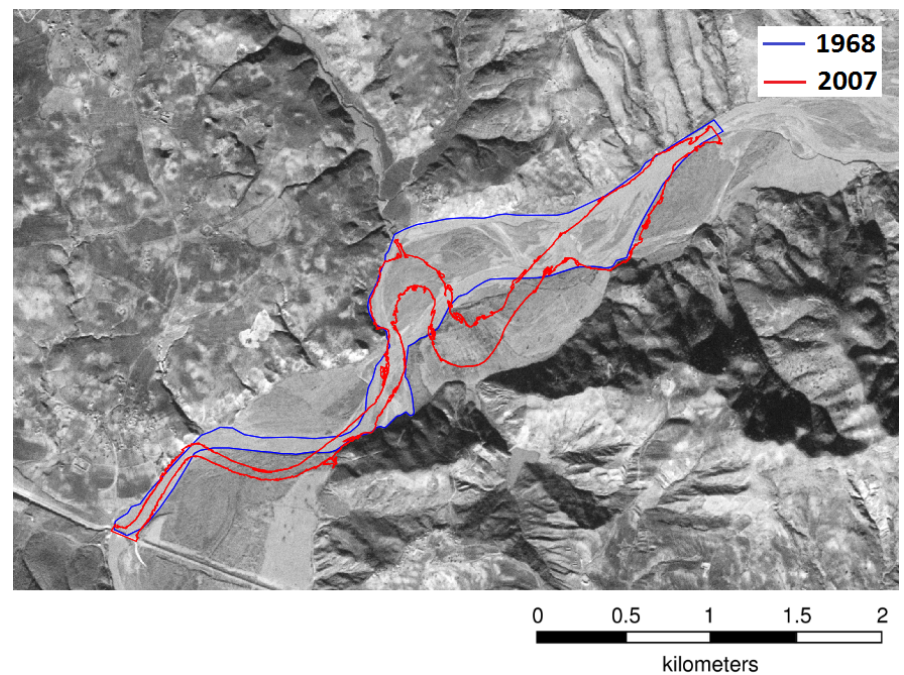
Figure 11. Historical comparison of active channel area, Seman